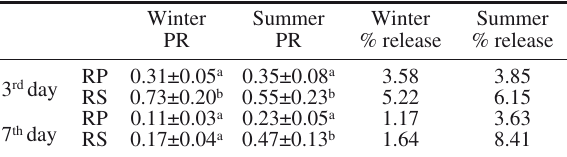
Table 7. – Release of phenolic compounds in seawater using phloro- glucinol as standard in C. tamariscifolia collected in winter (Febru- ary) and summer (July) from rocky shores (RS) and rockpools (RP). Data are expressed as mean (SD) percentages of phenol released to total internal content (% release) after 3 and 7 d culture in 1.5-L cylindrical vessels under solar radiation, n=6 and lower-case